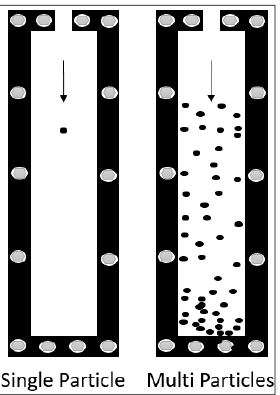
Figure 15. Solid particle effect in confined fracture fluid system.